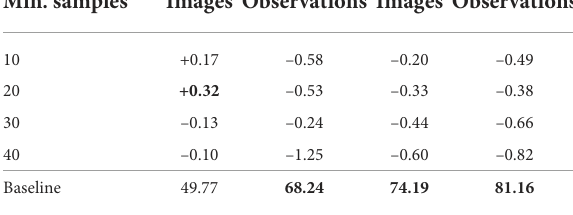
TABLE 7 Impact of additional noisy data on classification